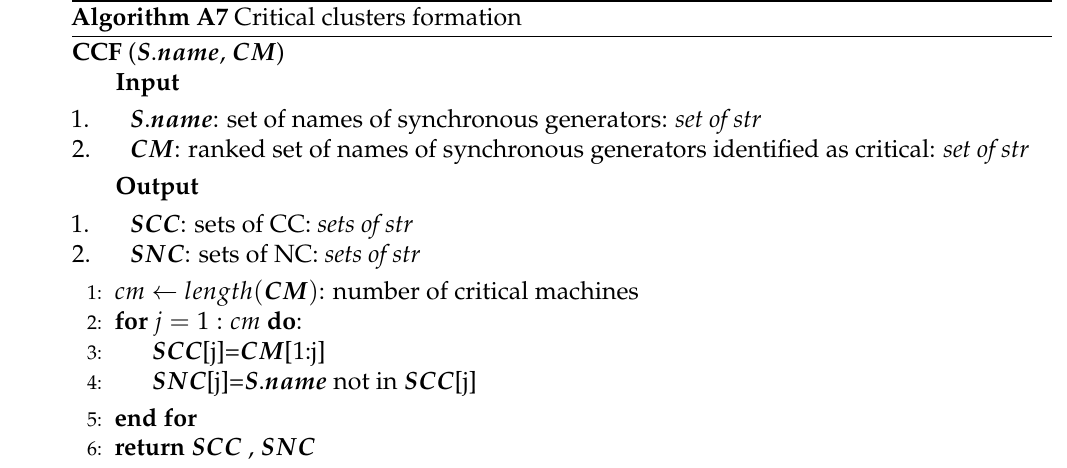
Algorithm A8 pseudocode details the function to estimate the time associated with a desired angle for the OMIB model. The function angle-to-time updates the time and OMIB angular speed interval by interval up to reaching the desired time associated to the desired angle. This function relies on Algorithm A9 pseudocode which presents the GTS function. For each interval, this function employs the Taylor series equations to find the time and angular speed associated to a desired angle using the interval initial